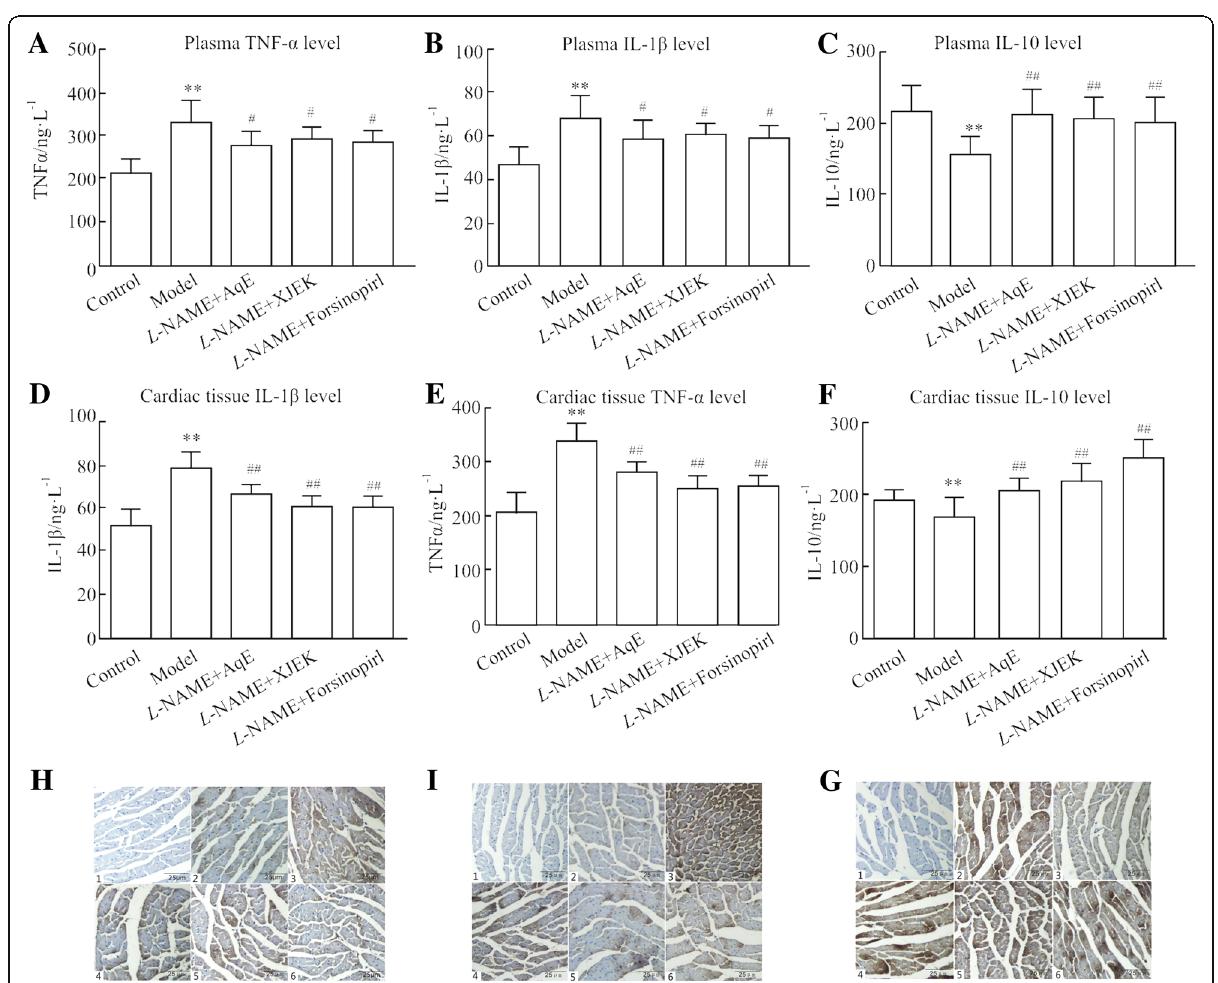
Fig. 8 Effects of polysaccharide extract from XJEK on TNF- α , IL-1 β and IL-10 in L -NAME-induced hypertensive mice. ( a ) TNF- α expression level in plasma. ( b ) IL-1 β expression level in plasma. ( c ) IL-10 expression level in plasma. ( d ) IL-1 β expression level in cardiac tissues. ( e ) TNF- α expression level in cardiac tissues. ( f ) IL-10 expression level in cardiac tissues. ( g ) Representative image of IL-1 β immunocytochemistry. ( h ) Representative image of TNF- α immunocytochemistry.( i ) Representative image of IL-10 immunocytochemistry.1,negative group; 2,control group; 3, model group; 4, L -NAME+AqE group; 5, L -NAME+XJEK group; 6, L -NAME+fosinopril group. Data are presented as the mean ± SD ( n = 10). ** P < 0.01 vs. control group; # P < 0.05, ## P < 0.01 vs, model group